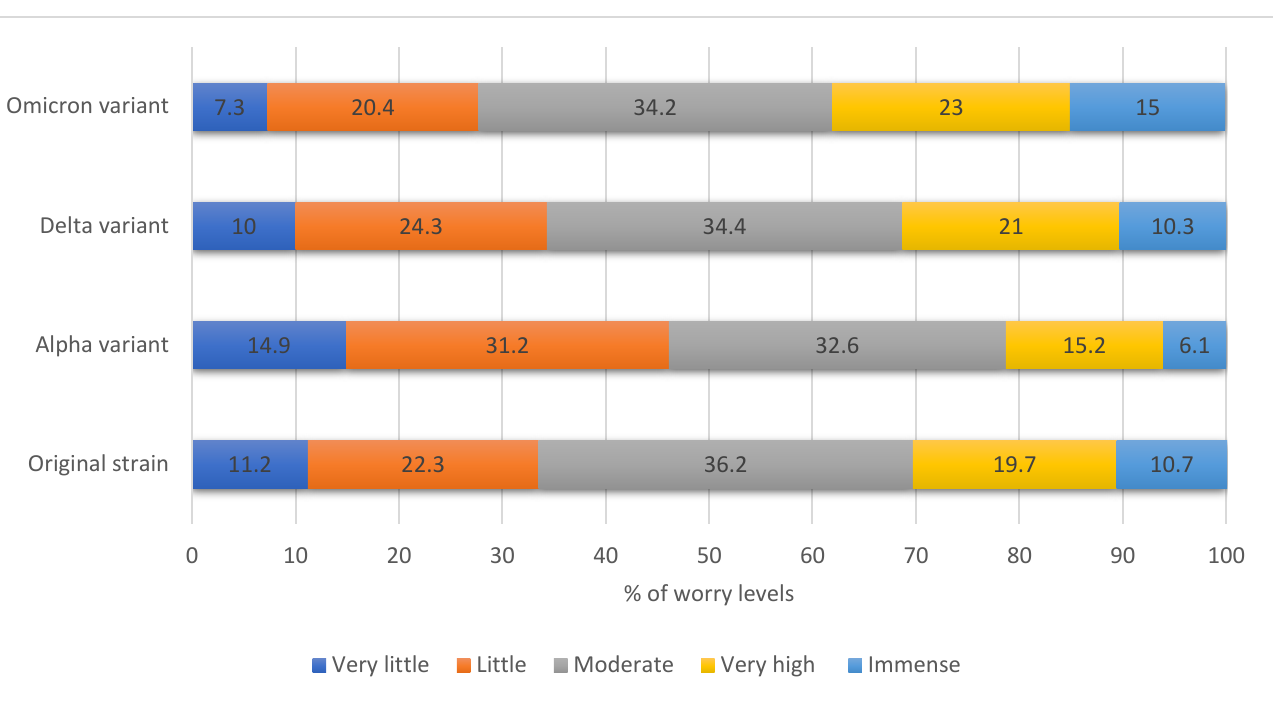
Figure 2. The HCWs’ perceived worry levels from various SARS-CoV-2 variants *. * Worries from original, alpha and delta strains were significantly lower than the worries from Omicron (paired samples t -test, p < 0.001 each, respectively). Table 3. Descriptive analysis of the HCWs’ stress, resilient coping, and intolerance of